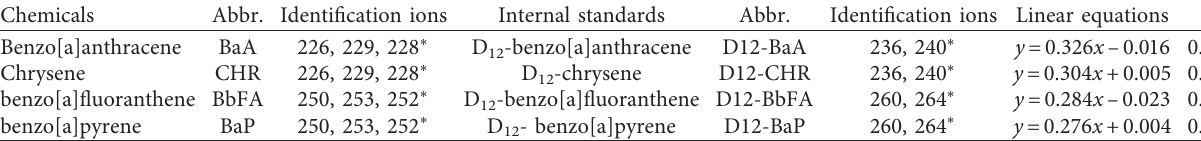
Table 1: Chemical monitoring ions and linear equations.